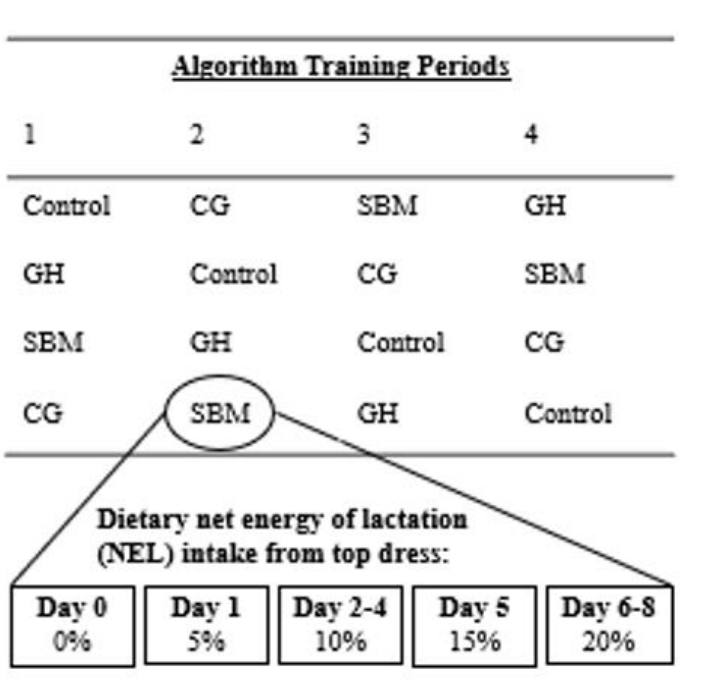
Figure 1. The experimental design consisted of four periods that were nine days in length. During each period, six cows were randomly assigned to one of four treatment options. Experimental treat- ments included: Control = TMR with no top dress; CG = TMR with corn grain top dress; SBM = TMR with soybean meal top dress; and GH = TMR with mixed grass hay top dress. A replicated 4 × 4 Latin square was implemented and each group of six cows was fed a different experimental treatment diet over the four periods. Cows were fed increasing amounts of dietary net energy of lactation (NE L ) intake from top dress over each period, as shown in the rectangles